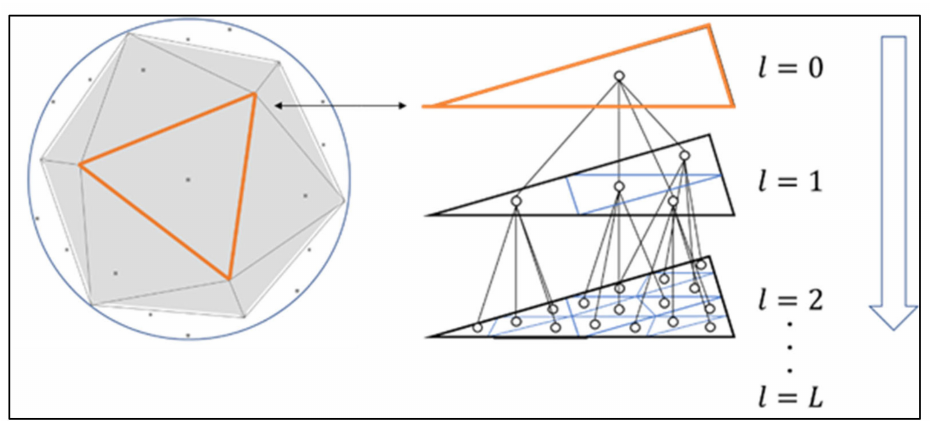
Figure 6. Structure of the